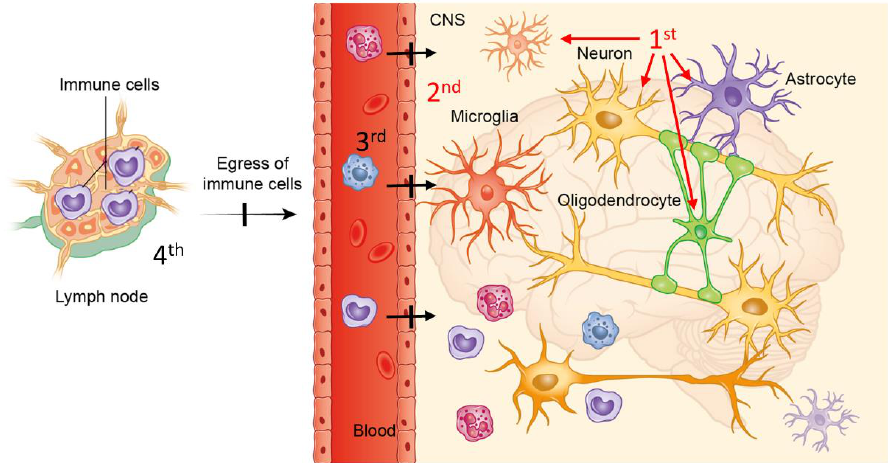
Figure 4. Proposed mode of action of siponimod: Schematic illustrating our proposed mode of action of siponimod. Note that following this concept, the anti-inflammatory activity of siponimod is at least in part due to direct interactions with brain cells. The copyright license of this illustration is with the authors.